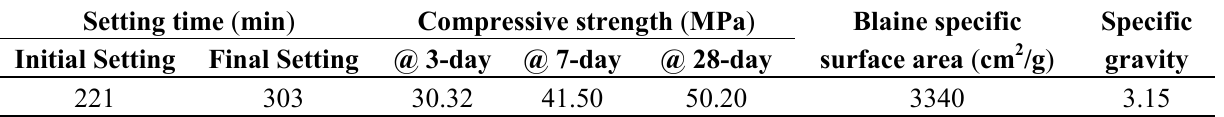
Table 2. Physical properties of Type I Ordinary Portland Cement.